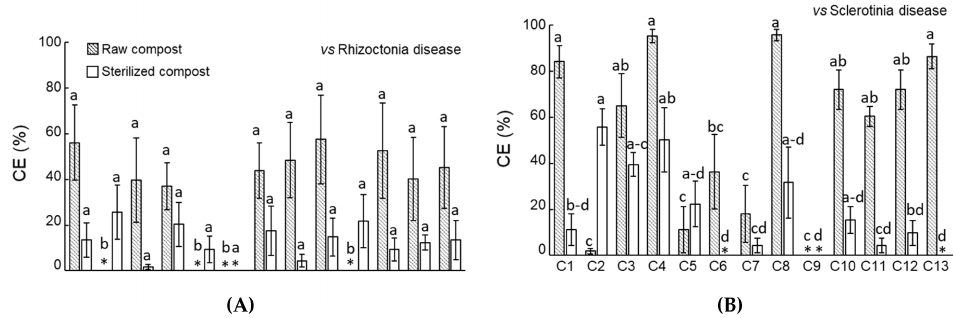
Figure 1. Control e ffi cacy percentage (CE%) of raw (grey bars) and autoclaved (open bars) composts (C1-13) on seedling cress damping-o ff incidence caused by Rhizoctonia solani ( A ) and Sclerotinia minor ( B ). Bars indicate the mean ± standard error. Di ff erent letters indicate significant di ff erences among bars of the same color according Tukey’s HSD test at p ≤ 0.05.